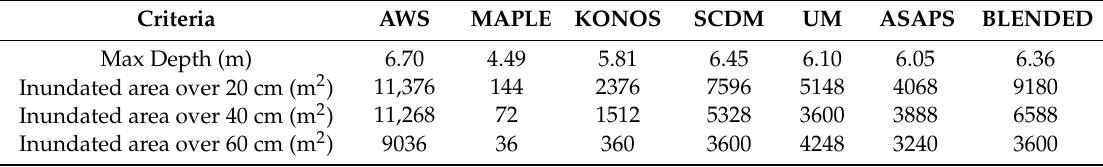
Table 4. Inundation forecast results in terms of max depth and inundated area for each criterion.